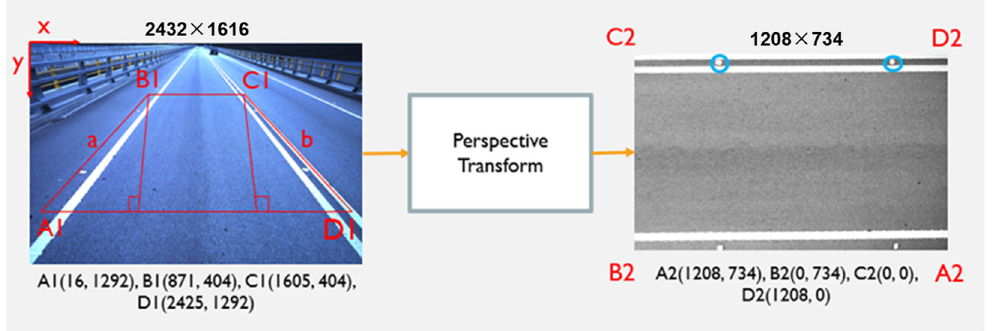
Figure 8. Selection of the region of interest ( left ) and the output of perspective transformation ( right ).